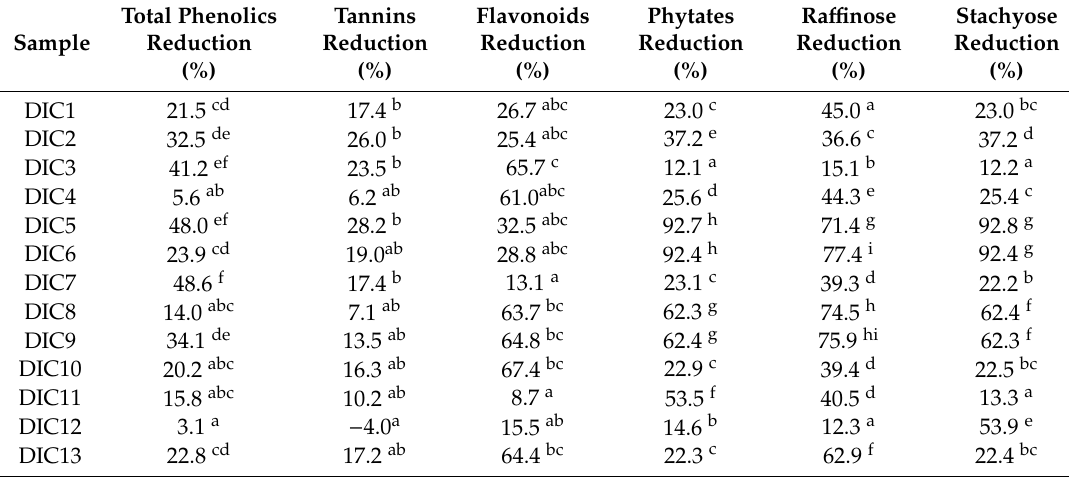
Table 3. E ff ect of DIC over total phenolics, condensed tannins, and